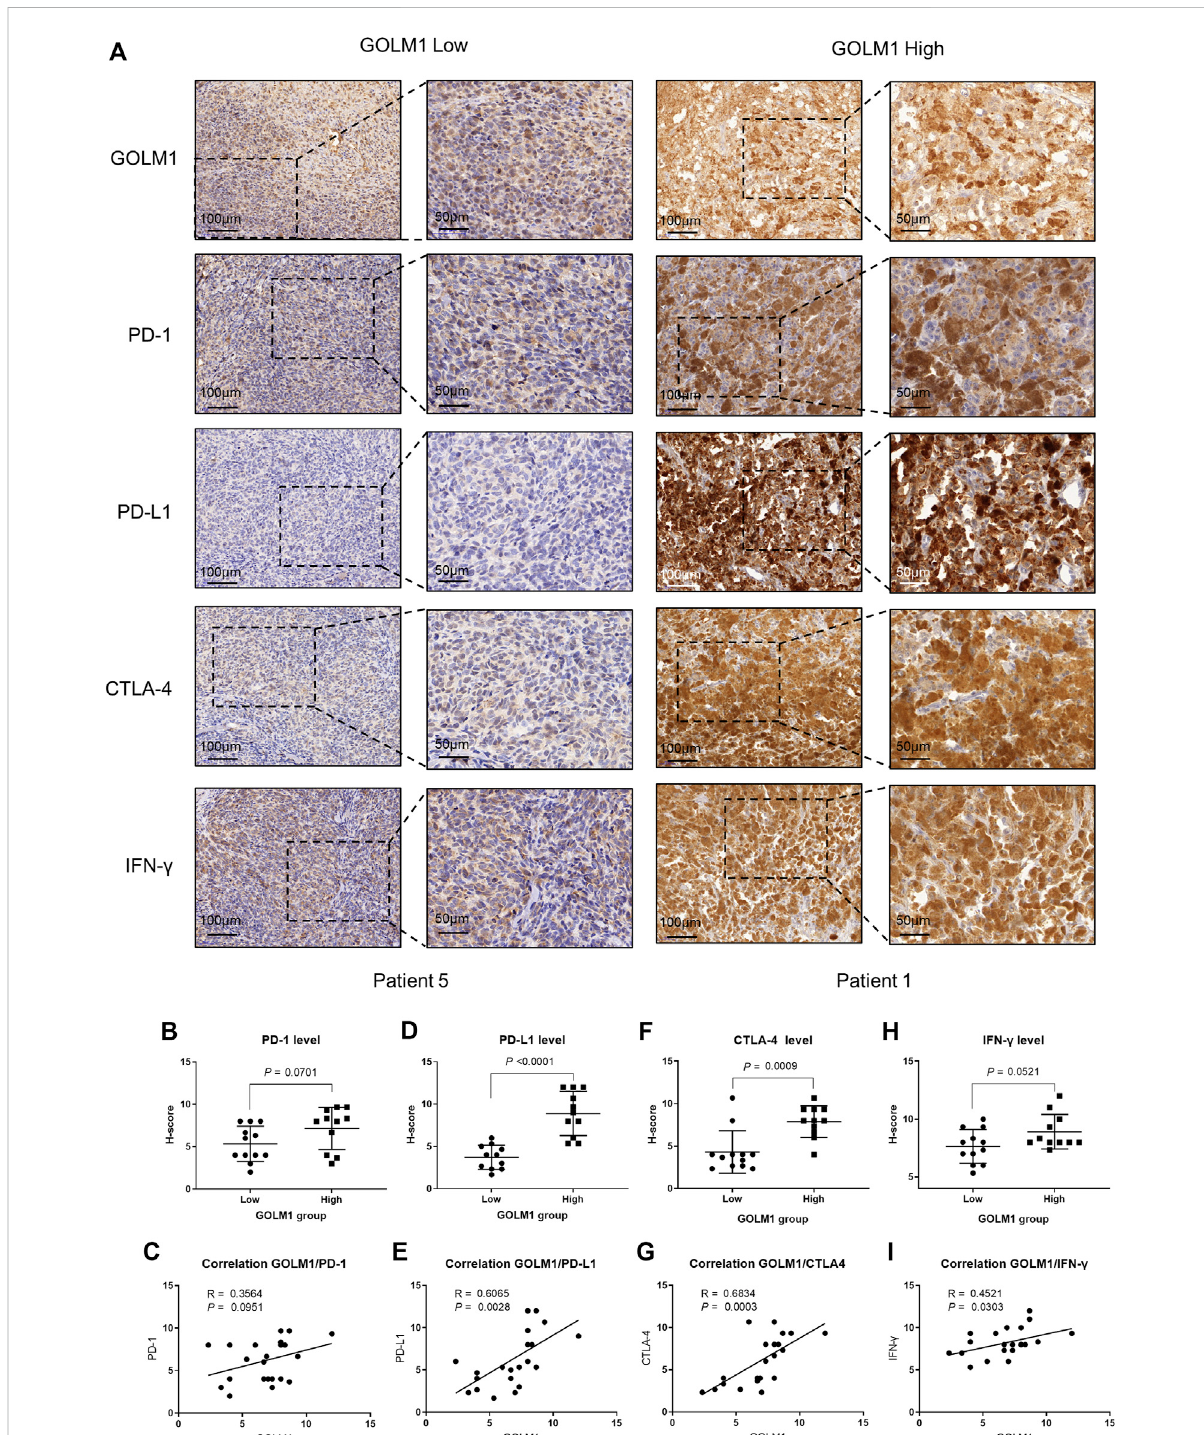
FIGURE 7 Correlation between GOLM1 expression and PD-1, PD-L1, CTLA4, and IFN- γ . (A) Immunohistochemistry assay revealed the protein expression of GOLM1, PD-1, PD-L1, CTLA4, and IFN- γ . (B,C) The expression difference of PD-1 among GOLM1-low (LEXP) and GOLM1-high (HEXP) subgroups (B) andthecorrelationbetweenPD-1andGOLM1expression (C) . (D,E) TheexpressiondifferenceofPD-L1amongtheLEXPandHEXPgroups (D) and the correlation between PD-L1 and GOLM1 expression (E) . (F,G) The expression difference of CTLA4 among the LEXP and HEXP groups (F) and the correlation between CTLA4 and GOLM1 expression (G) . (H,I) The expression difference of IFN- γ among the LEXP and HEXP groups (H) and the correlation between IFN- γ and GOLM1 expression (I)